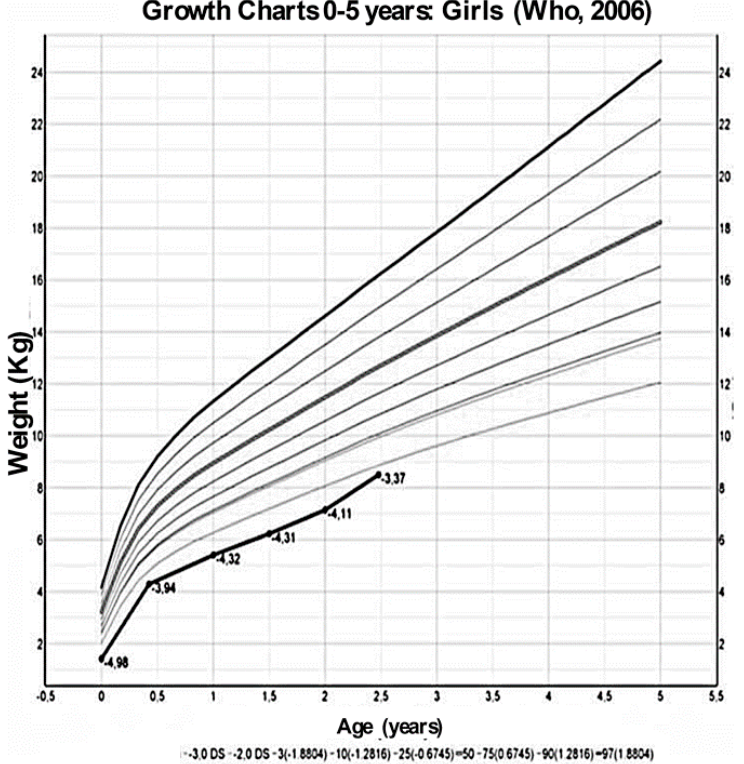
Figure 3. Growth charts, from Who 2006 [13], of the weight of the patient at different ages.